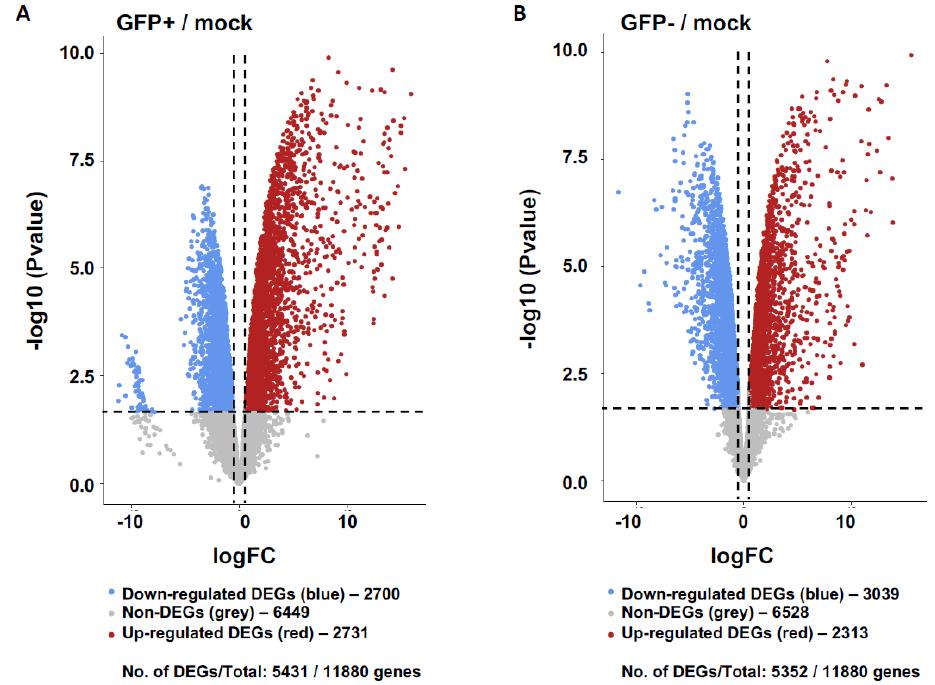
Figure 1. Transcriptomics of GFP+ (RRV-infected) and GFP − (uninfected bystander) populations relative to mock controls of primary human chondrocyte cells. Gene expression of GFP+ cells ( A ) and GFP − cells ( B ) relative to healthy mock controls are shown represented as volcano plots. Differentially expressed genes (DEGs) defined whereby log2 Fold Change (FC) threshold of 0.58 (1.5FC) and False Discovery Rate (FDR) <0.05. The down- and up-regulated DEGs are coloured blue and red, respectively, and non-significant genes are shown in grey.